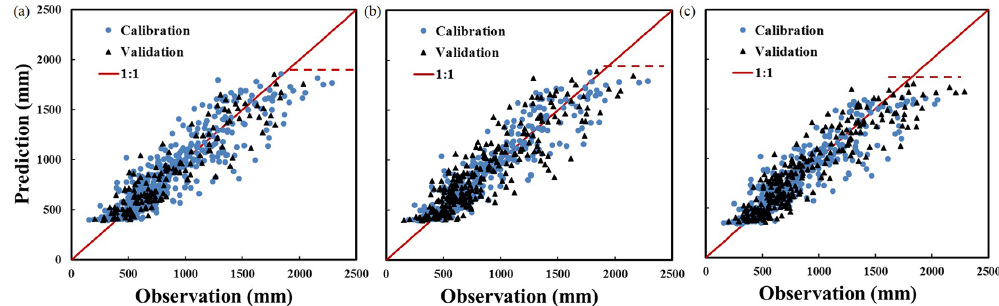
Figure 5. Comparison in annual precipitation between the gauged measurements and predictions by the regression model for scenar- ios (a) fully random; (b) all gauges, partial period; and (c) partial gauges, entire period. Details of the three scenarios refer to Sect. 2.2. Table 1. Regression model performance and regression coefficients.